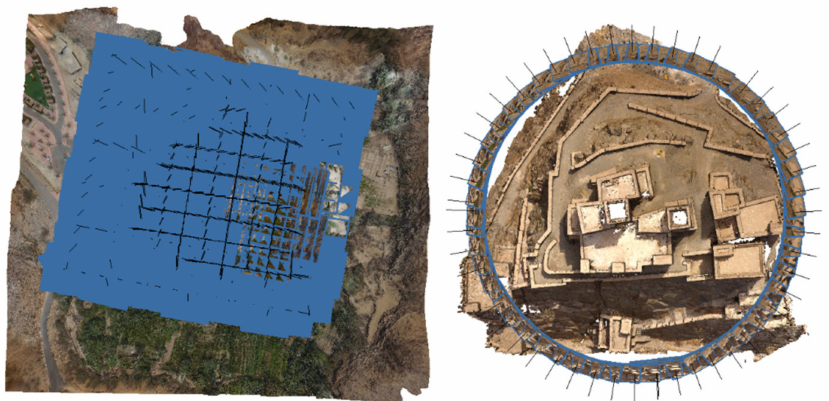
Figure 9. Photo acquisition with UAVs (nadir and oblique trajectory).